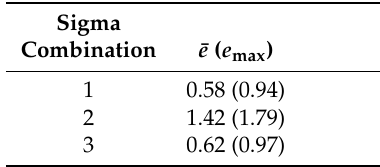
Table 7. Mean position error ¯ e and maximum error e max (in brackets) of the first walk combinations of 8 pedestrians starting at different starting positions in front of the building for partly successive FeetSLAM. The number of iteration was 3 and the window size was 3. The results are given for varying sigma values for the SCs (line 1 and 2) and additionally disturbing the SCs (line 3). The respective sigma values are given in Table